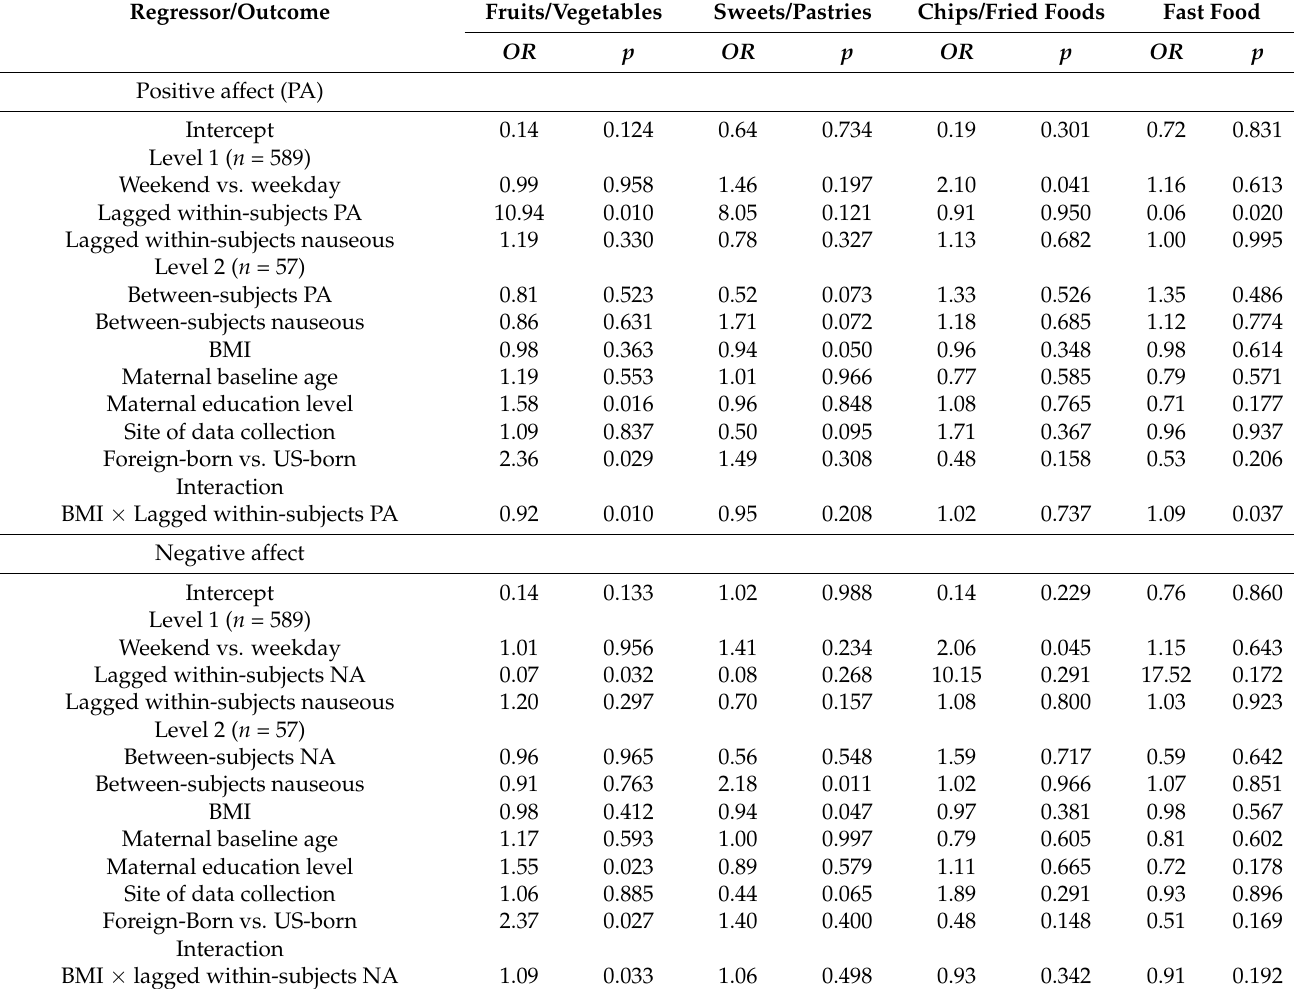
Table 2. Results of Multilevel Logistic Models Testing Affect Predicting Subsequent Food